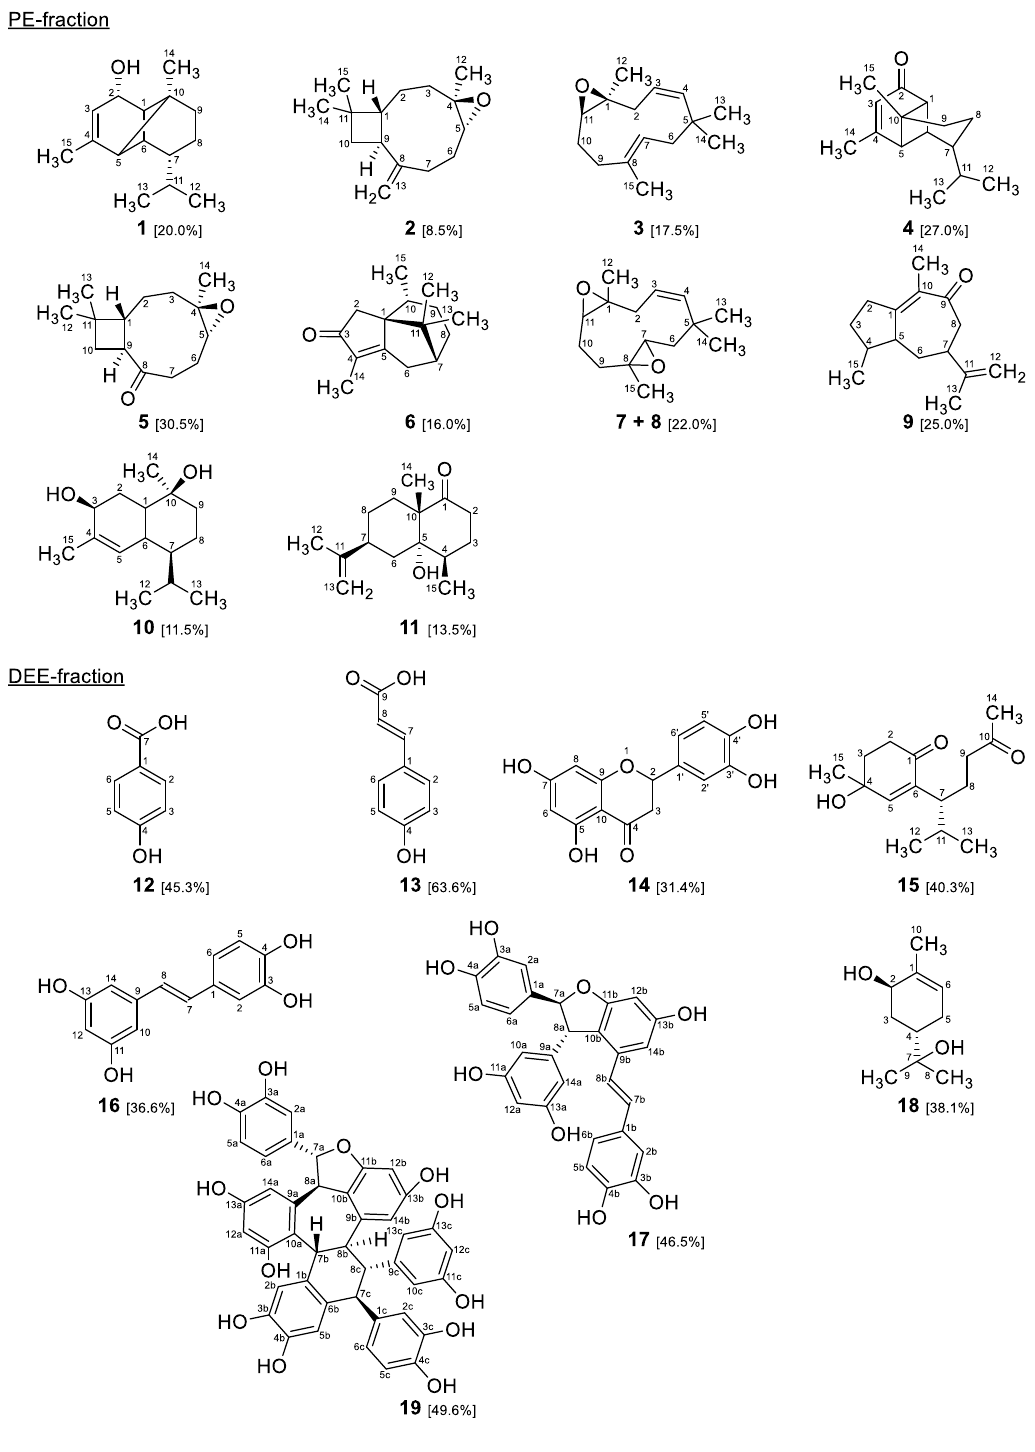
Figure 3. Compounds 1 – 19, isolated from the subaerial parts from Cyperus articulatus . In brackets: NO production inhibition (% inhibition vs. LPS) of isolated compounds from J774A.1 murine macrophages at a test concentration 10 µM. Sesquiterpenes 1 , 3 – 5 , 9 , and 10 , phenolic acid compound 13, and terpenoid compound 18 showed high antiproliferative properties in the performed MTT assay (Tables S1 and